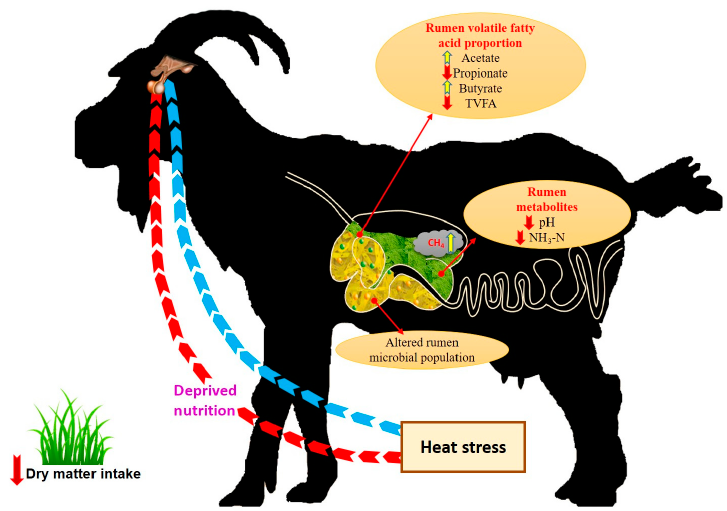
Figure 1. Impact of heat stress on various rumen functions in goat (these concepts were adopted from References [28,29]). TVFA: Total Volatile Fatty Acid.